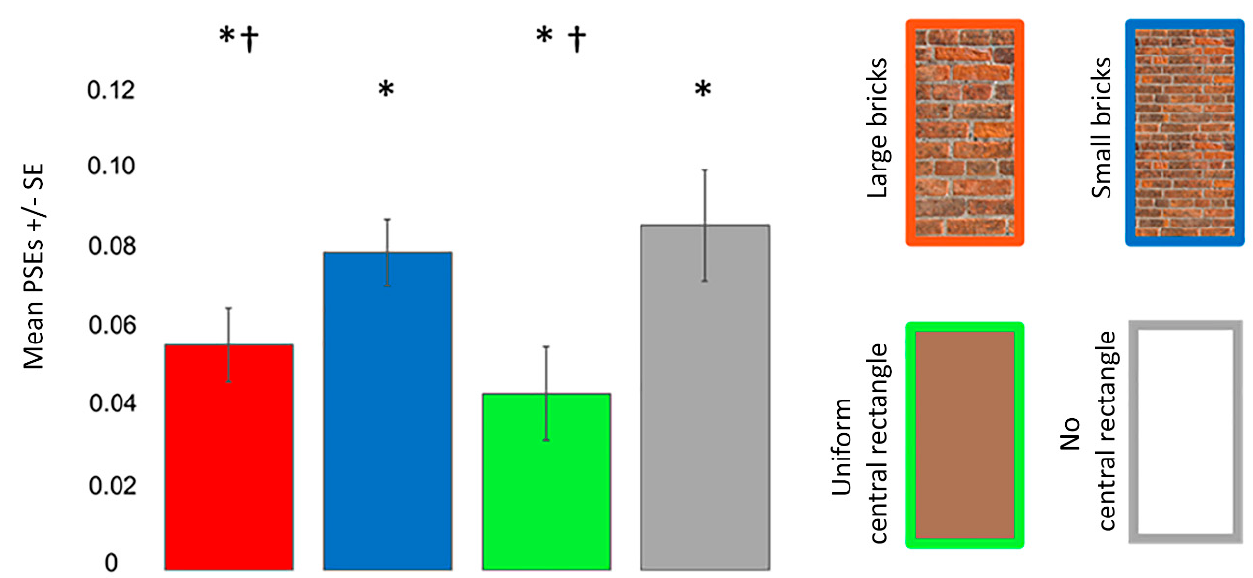
Figure 7. PSEs for the different Poggendorff stimuli in experiment 2. Daggers (†) denote differences from the no central rectangle condition at p < 0.050 after correcting for multiple comparisons using the Bonferroni method. Asterisks (*) denote differences from the physical width at p < 0.050 after correcting for multiple comparisons using the Bonferroni method. PSEs were computed from psychometric functions. Error bars denote standard errors for within-subject contrasts as described by O’Brien and Cousineau [22].